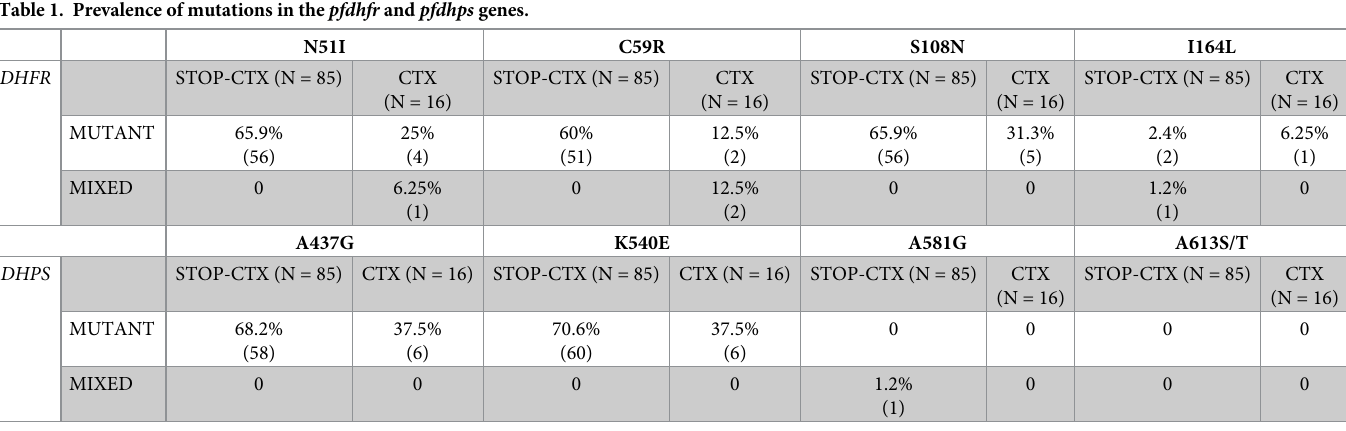
Note: Mutation distribution per codon was calculated as a percentage of the total number of P . falciparum positive samples in each arm as indicated (N). Mutations were tallied autonomously per codon as an overall